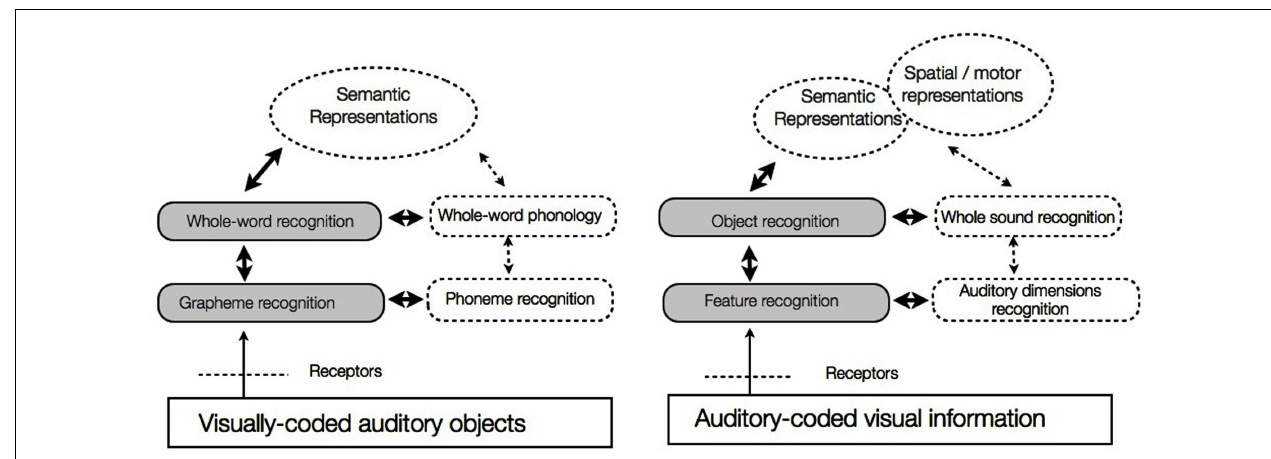
FIGURE 2 | Further analogies between reading and integration of visual-to-auditory sensory substitution devices. Full arrows indicate new elements brought about by training and new devices or artifacts, dotted arrows indicate elements that